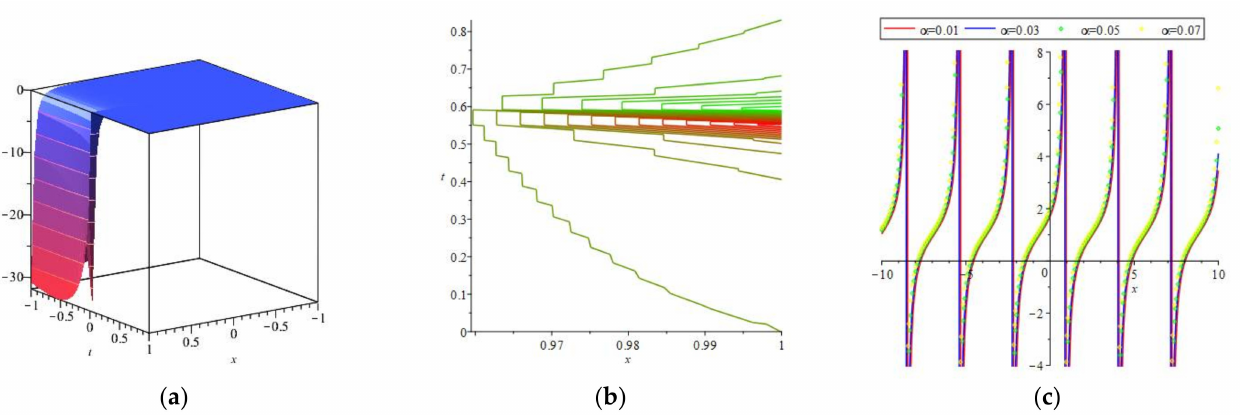
Figure 6. The graphical representation of the solution λ 33 ( χ ) : ( a ) 3D shape, ( b ) contour plot, and ( c ) 2D graph.